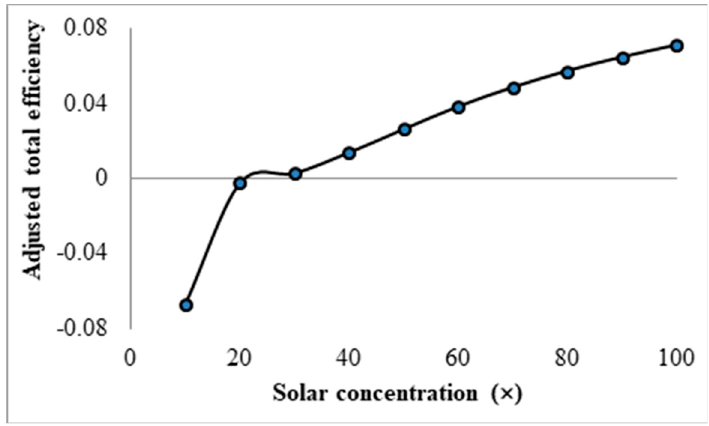
Figure 17. Effect of solar concentrations on adjusted total efficiency.